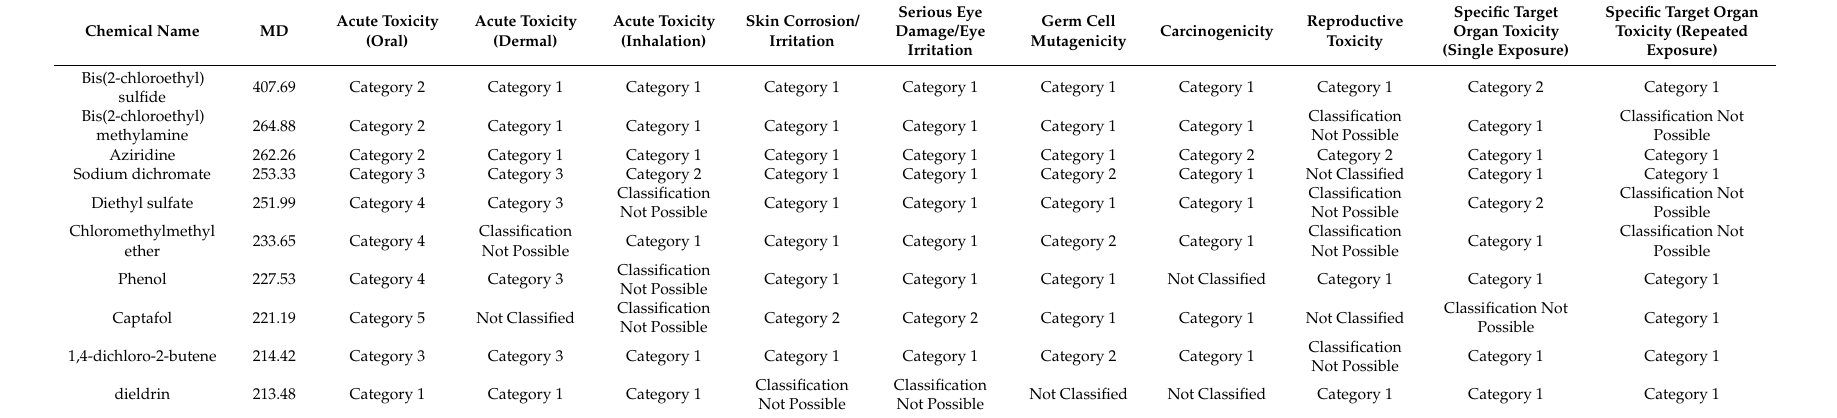
Table 5. Top 10 chemicals with large Mahalanobis distances